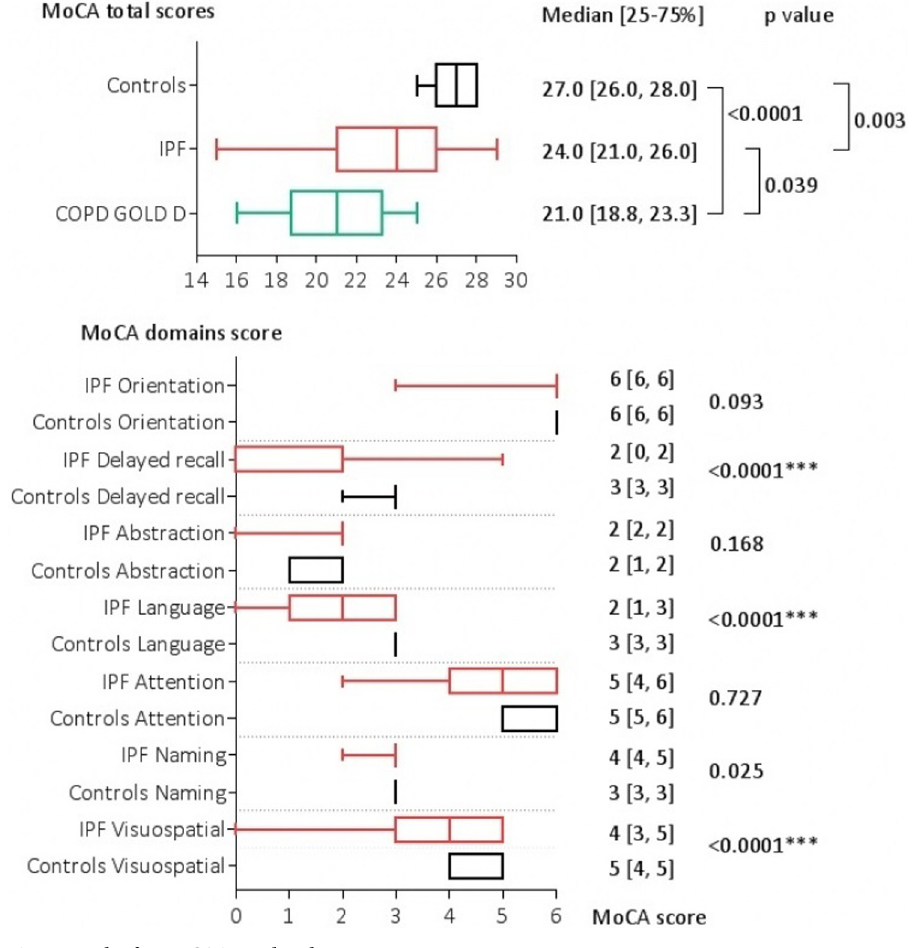
Fig 1. BoxPlot for MoCA in study